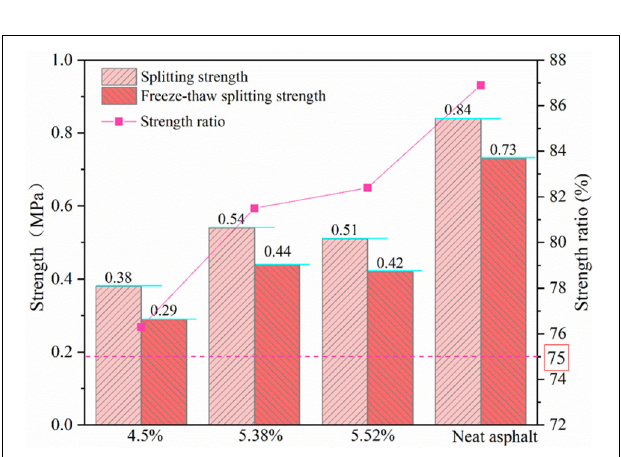
FIGURE 8 | Freeze-thaw splitting test results for CPAM.